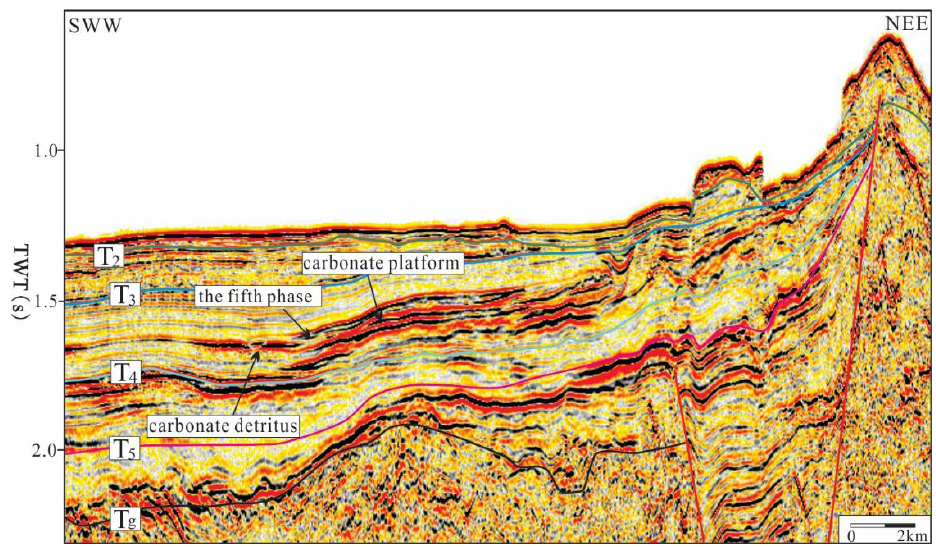
Figure 10. Seismic profile of the carbonate platform north of the Xisha Uplift. The profile location is shown in Figure 1B.